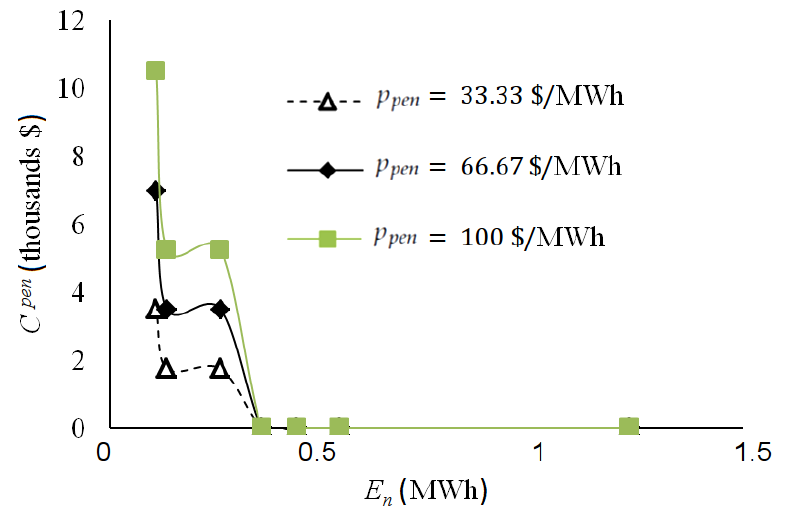
Figure 8. Penalization cost.